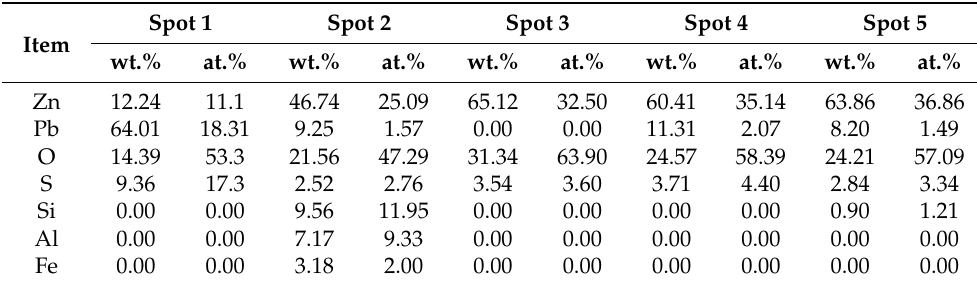
Figure 3. SEM image and EDS analysis areas of the GCR. Table 3. The EDS analysis results of the selected area of the raw material sample GCR in Figure 3a.